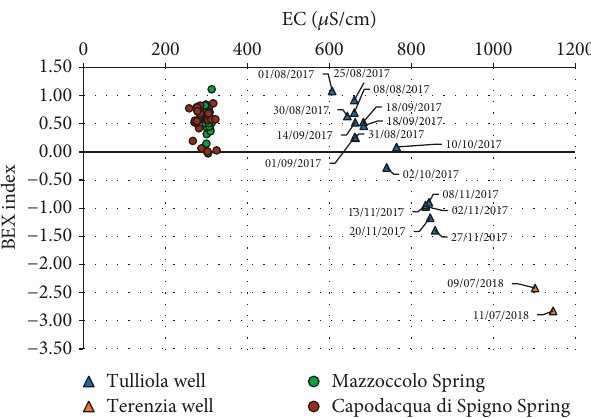
Figure 12: Scatter plot of electrical conductivity (EC) vs. the BEX index.